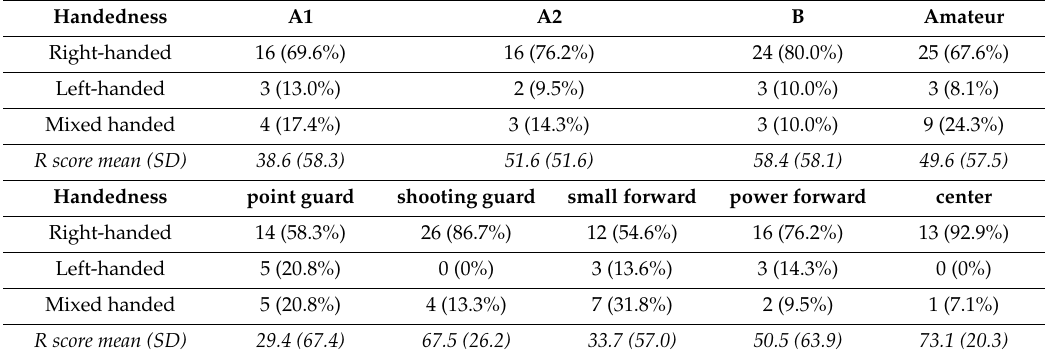
Table 4. Absolute and percent (in parenthesis) frequencies within each category of hand preference (BaHI inventory) and R scores among basketball divisions (above) and roles